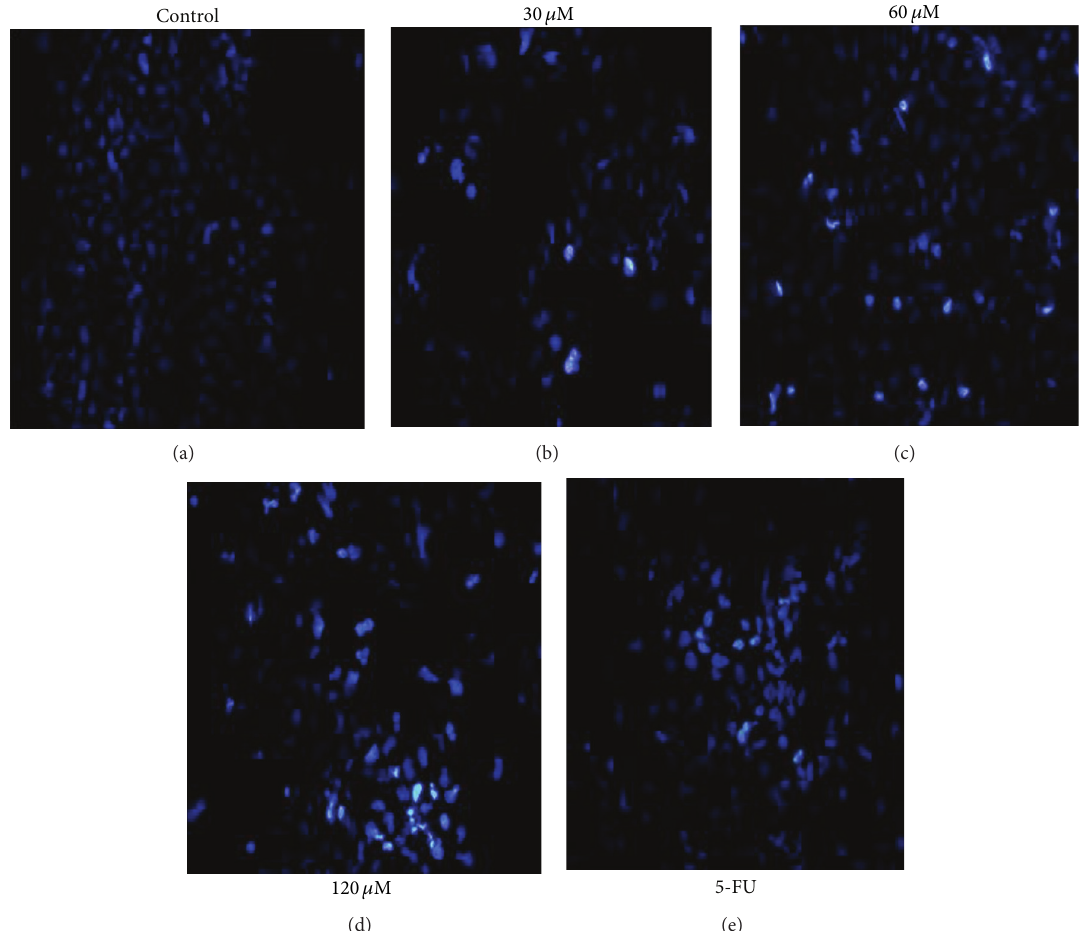
Figure 8: Effects of complex 2 on the morphology of Bel-7402 cells were assayed by Hoechst 33342 staining. After treatment with complex 2 for 48h, apoptotic cells were detected by Hoechst 33342 staining and examined by fluorescence microscopy (original magnification 400x).